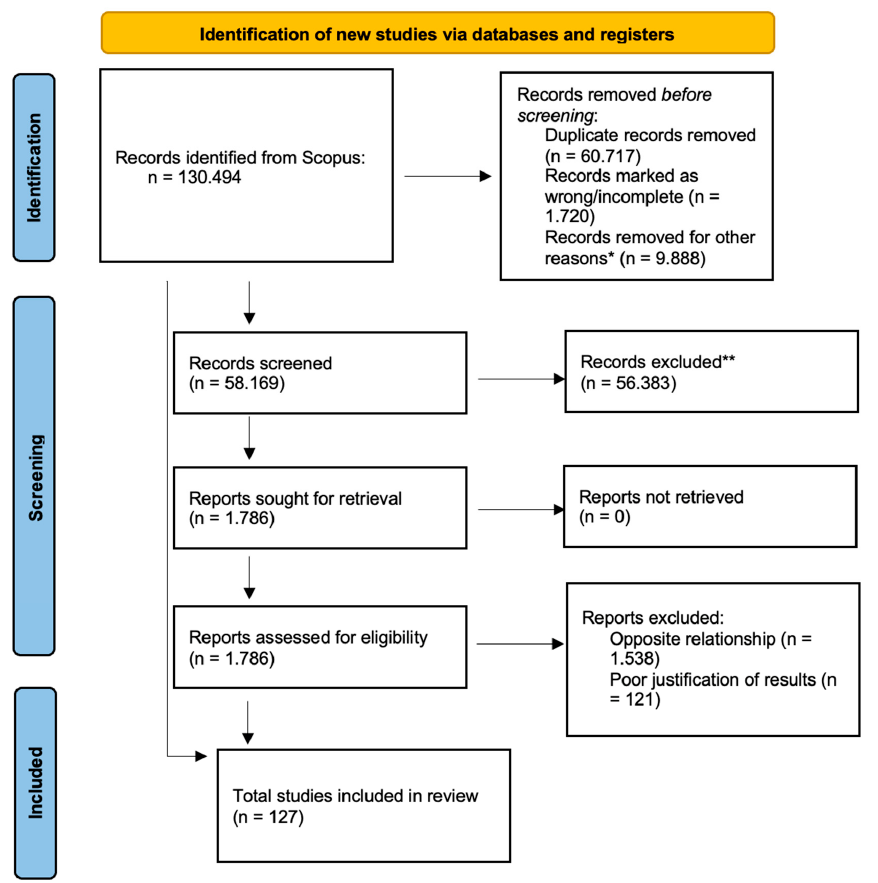
Figure 1. Flowchart of the literature-selection process based on the PRISMA approach. * Other exclusion criteria included entries that were not articles, letters, reviews. or surveys. ** Records excluded due to not being written in English, being of poor quality, and not having more than ten citations (for papers published up to 2020).